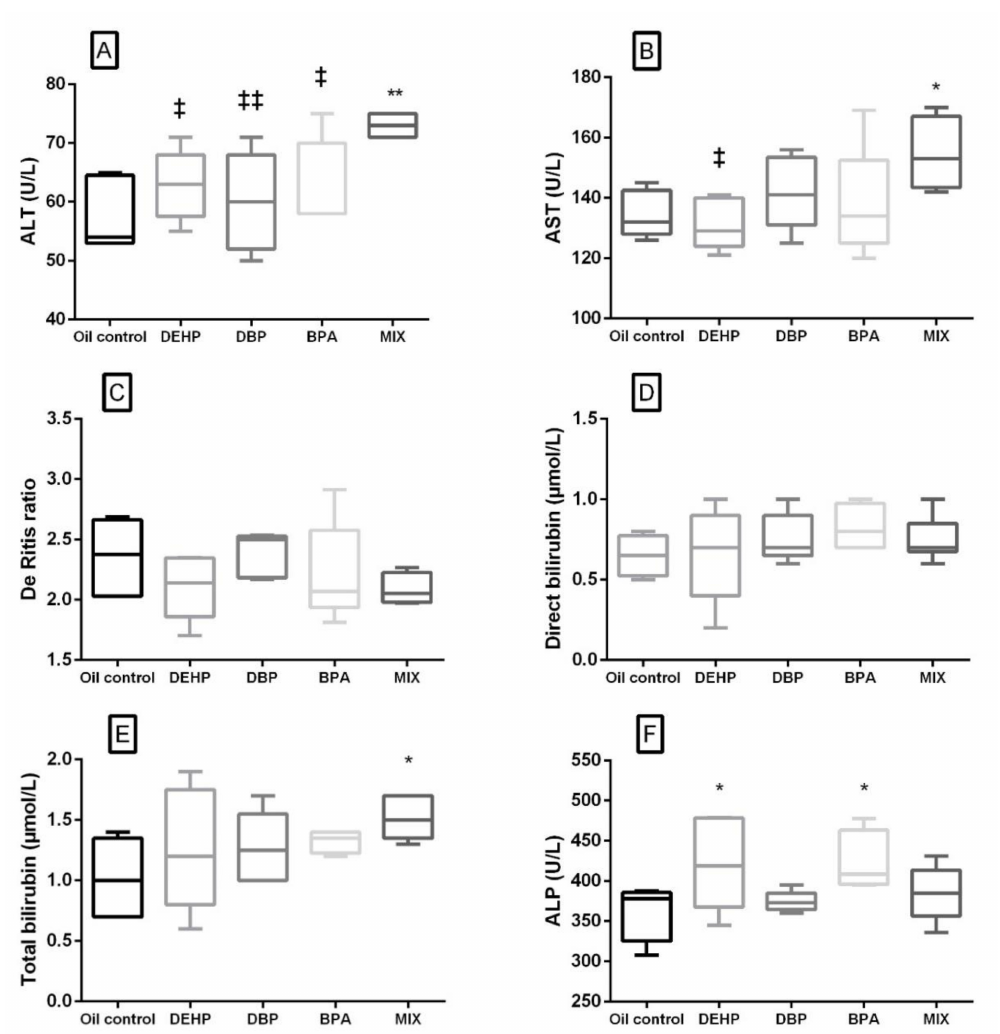
Figure 2. Liver-related serum biochemical parameters after 28 days of oral exposure to single investigated substances and their mixture (MIX). Each box plot represents interquartile range (25–75th percentile), the line within the box represents median value, and ends of the whiskers represent the minimum and maximum values within the group. ( A ) ALT activity (U / L), ( B ) AST activity (U / L), ( C ) the De Ritis ratio (AST / ALT), ( D ) direct bilirubin concentration ( µ mol / L), ( E ) total bilirubin concentration ( µ mol / L), ( F ) ALP activity (U / L) ((DEHP, DBP and BPA) * p < 0.05, ** p < 0.01 (compared to the control), ‡ p < 0.05, ‡‡ p < 0.01 (compared to the MIX